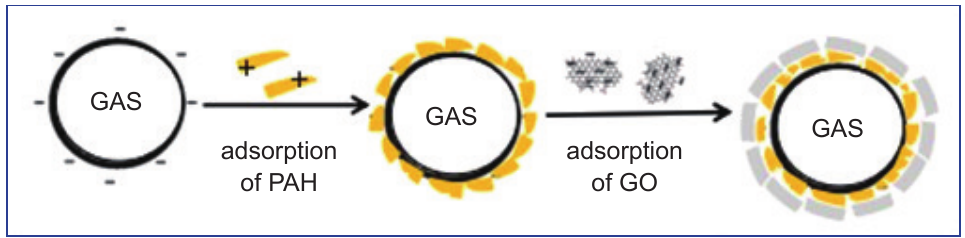
Figure 1 Schematic illustration of preparation of GO/PLA microbubbles (PLA@GO). The freshly prepared PLA microbubble with negative surface charge. By the absorption of PAH, successfully obtain the microbubbles with positive surface charge. Then the adsorption of GO changes the surface into negative surface charge in enable to absorb metal